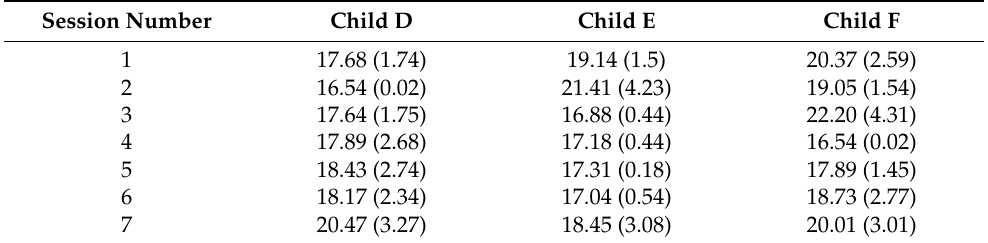
Table 9. Subset two: Children’s mean response time in seconds for successful answers (SD) in the IMITATE activity. In general, the response time increased in the last session. Session Number Child D Child E